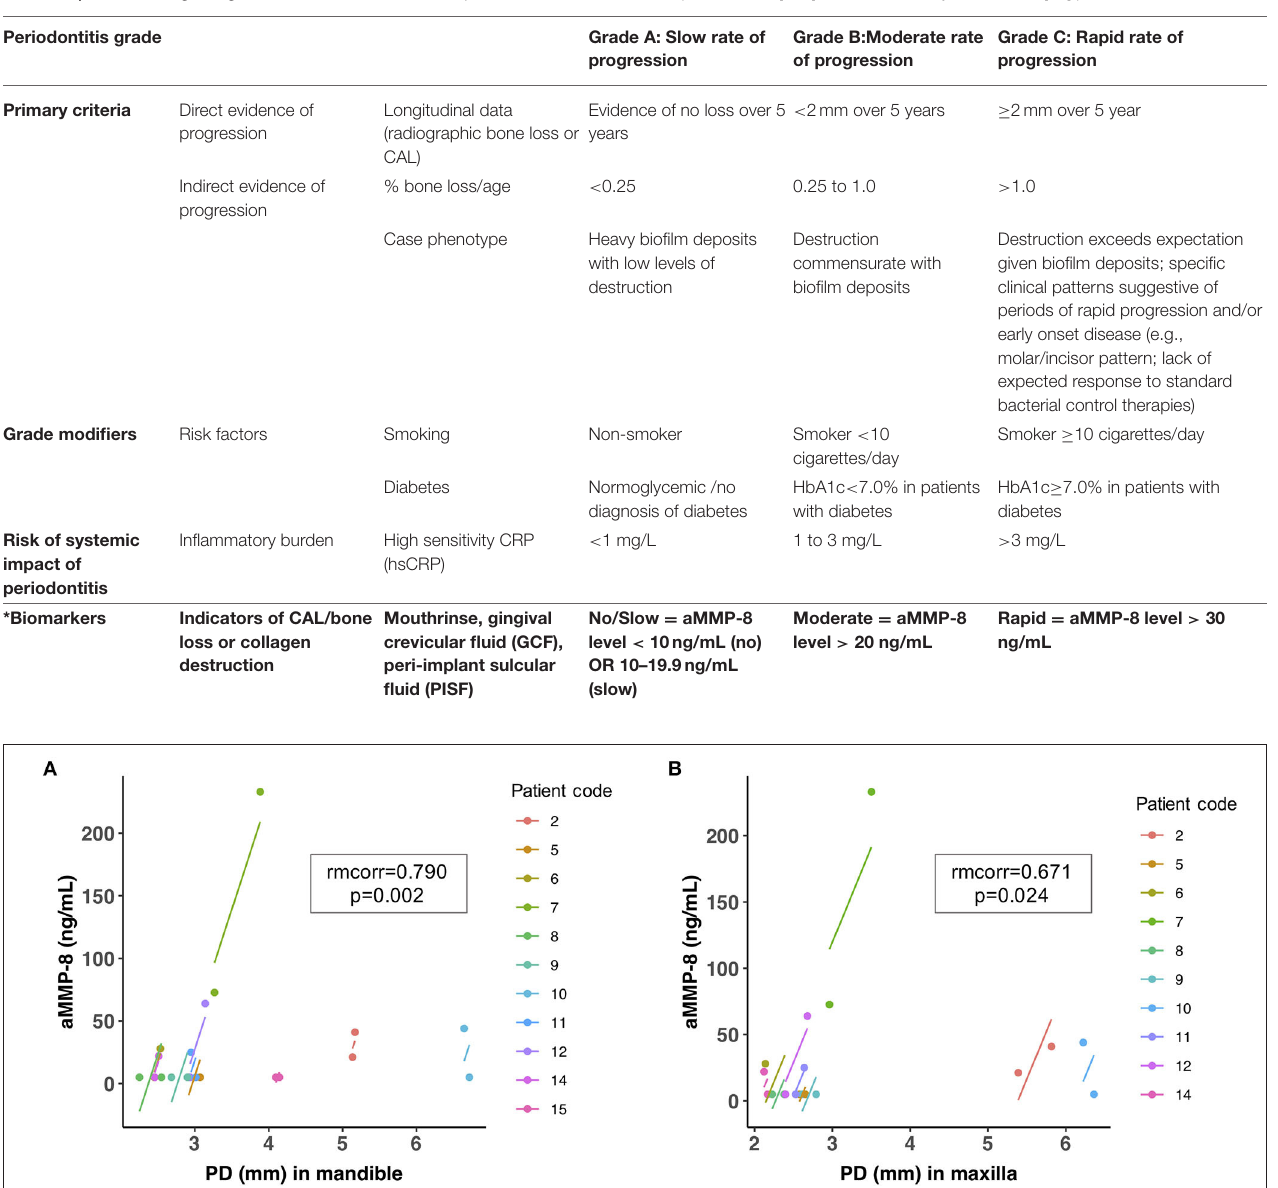
FIGURE 2 | Repeated measures correlation (rmcorr) plot for significant positive correlation between aMMP-8 levels in mouthrinse and probing depth (PD, [mm]) in (A) mandible and (B) maxilla that were measured before radiotherapy and 1 month after the end of radiotherapy for 11 head and neck cancer patients as described in Keskin et al.